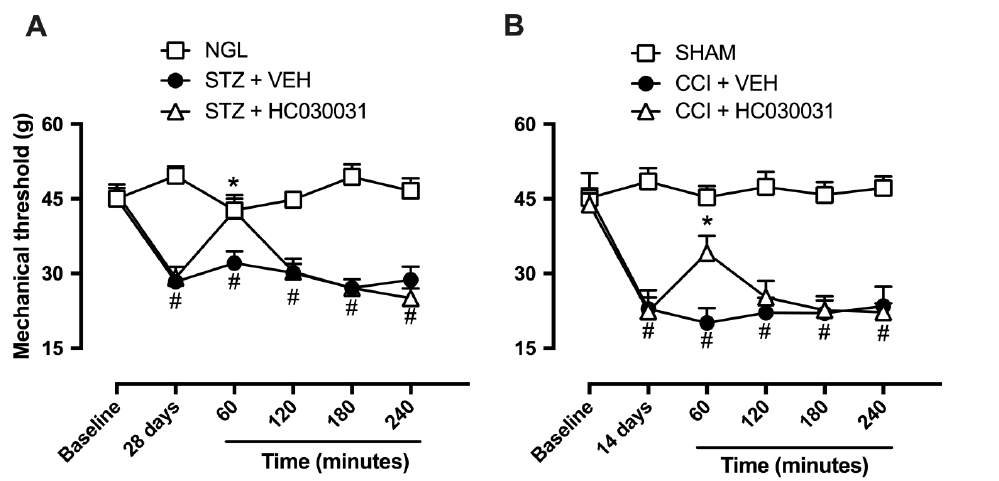
FIGURE 2 - Effect of the intraplantar (ipl) injection of a TRPA1 agonist, on mechanical allodynia in (A) diabetic (STZ) and (B) CCI rats. Diabetic (28 days after confirmation) and CCI (14 days after surgery) animals received ipl injection of HC-030031 (300 μg/40 μL/paw) and had their mechanical threshold reassessed 60, 120, 180 and 240 min after treatment. Values represent mean ± SEM. # indicates p<0.05 when compared to control groups (NGL or SHAM) and * indicates p<0.05 when in comparison to the diabetic or CCI group treated with vehicle (STZ+VEH or CCI+VEH). Repeated-measures two-way ANOVA followed by Bonferroni’s post hoc